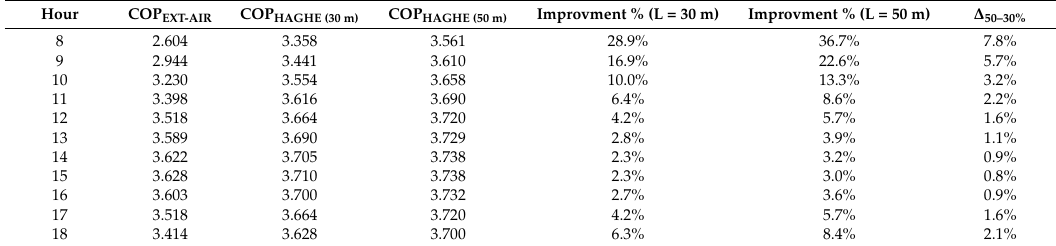
Table 7. Hourly performance improvement (%) of COP respect of untreated case by varying probe